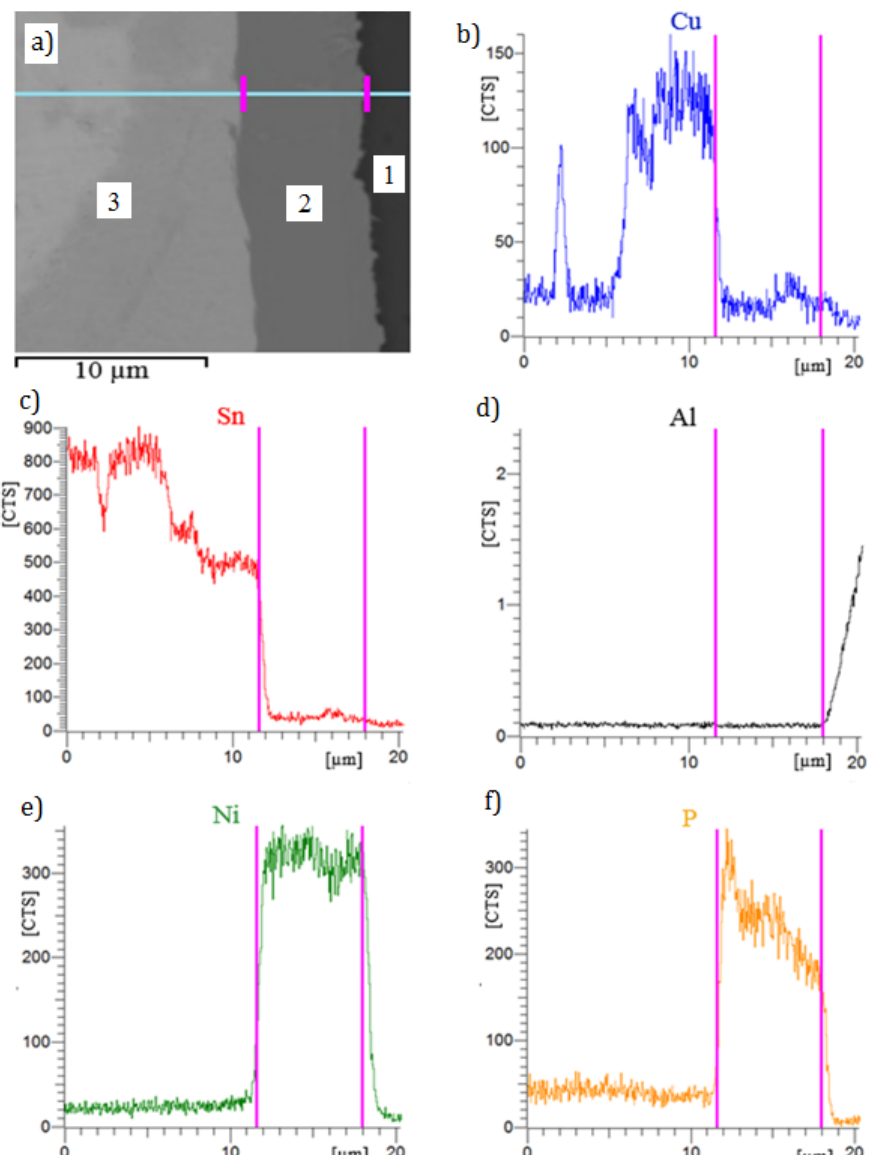
Figure 8. BSE (Back Scattered Electrons) image of transition zone of soldered joint made via Ni-P interlayer ( a ) and linear content of elements ( b – f ): 1—substrate (aluminum 7075), 2—Ni-P interlayer, 3—solder.